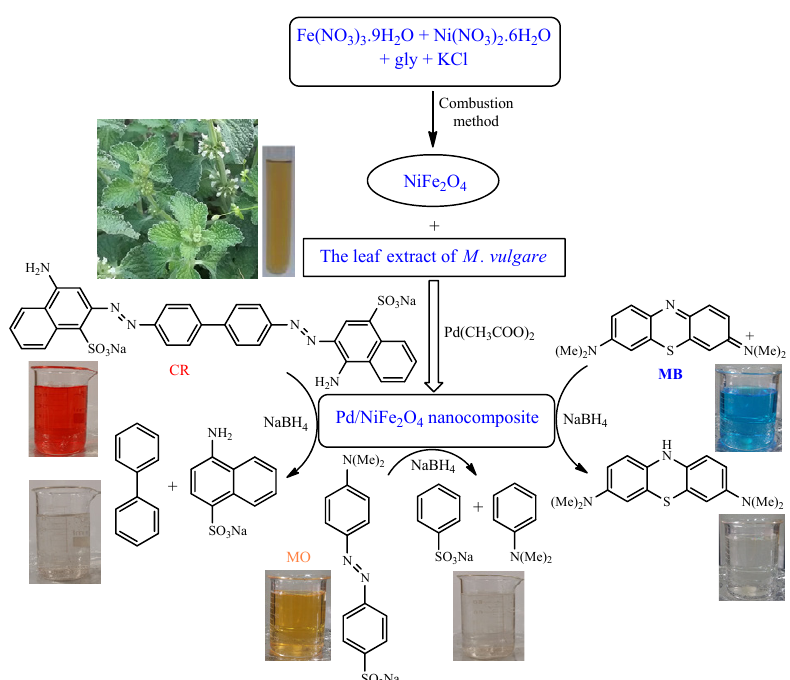
Fig. 4. Magnetization curve of the NiFe 2 O 4 nanocomposite.